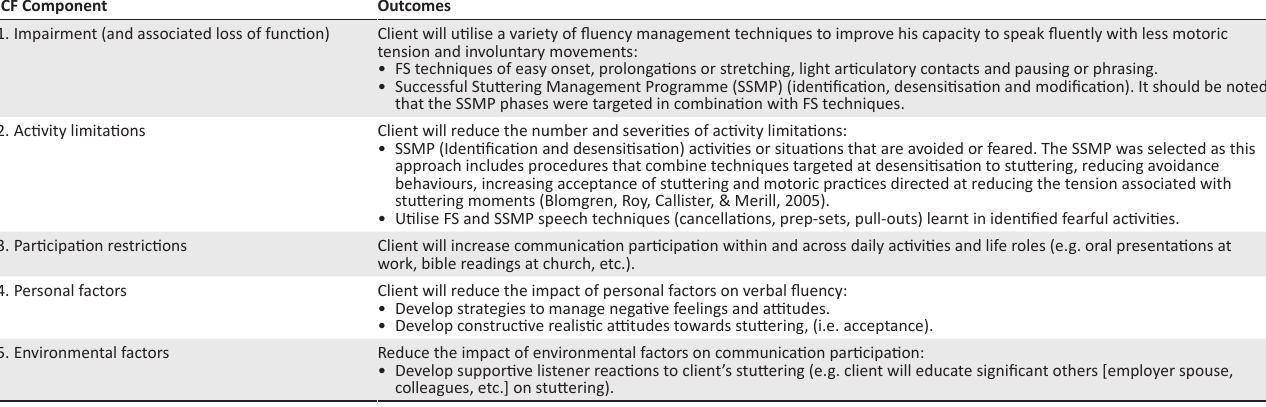
TABLE 1: Expected outcomes associated with components of the International Classification of Functioning, Disability and Health (ICF) framework. ICF Component